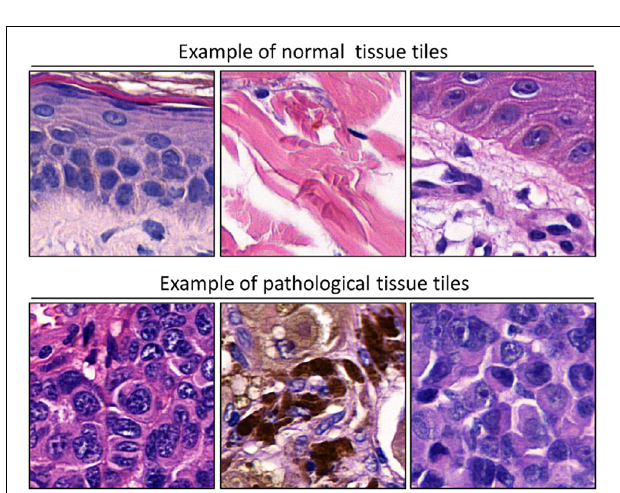
FIGURE 2 | Examples of patches cropped from ROIs. The first and second lines report sampled patches of normal and pathological tissues, respectively. Each patch has a size of 299 × 299 pixels (72.59 mm × 72.59